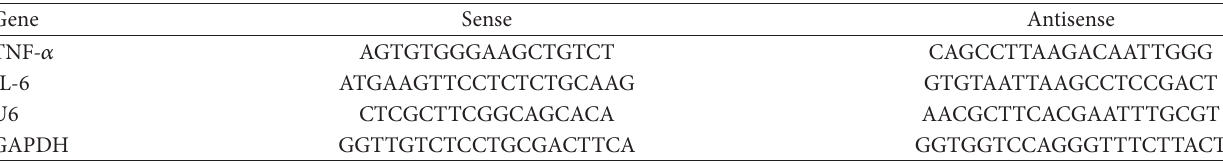
Table 1: Sequences of the primers use for